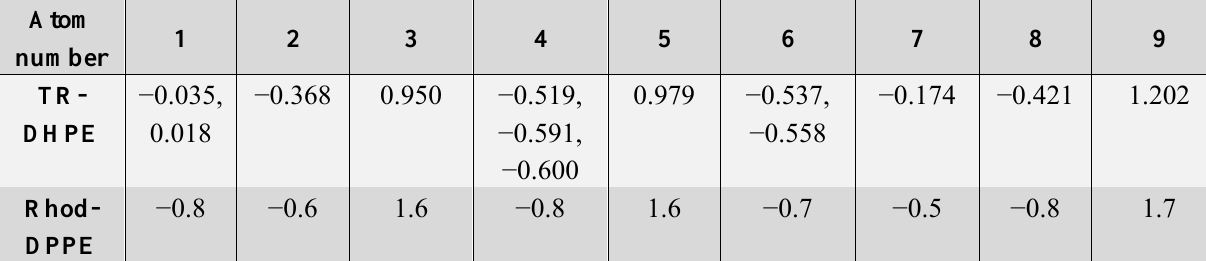
TR-DHPE [39] and Rhod-DPPE [40].